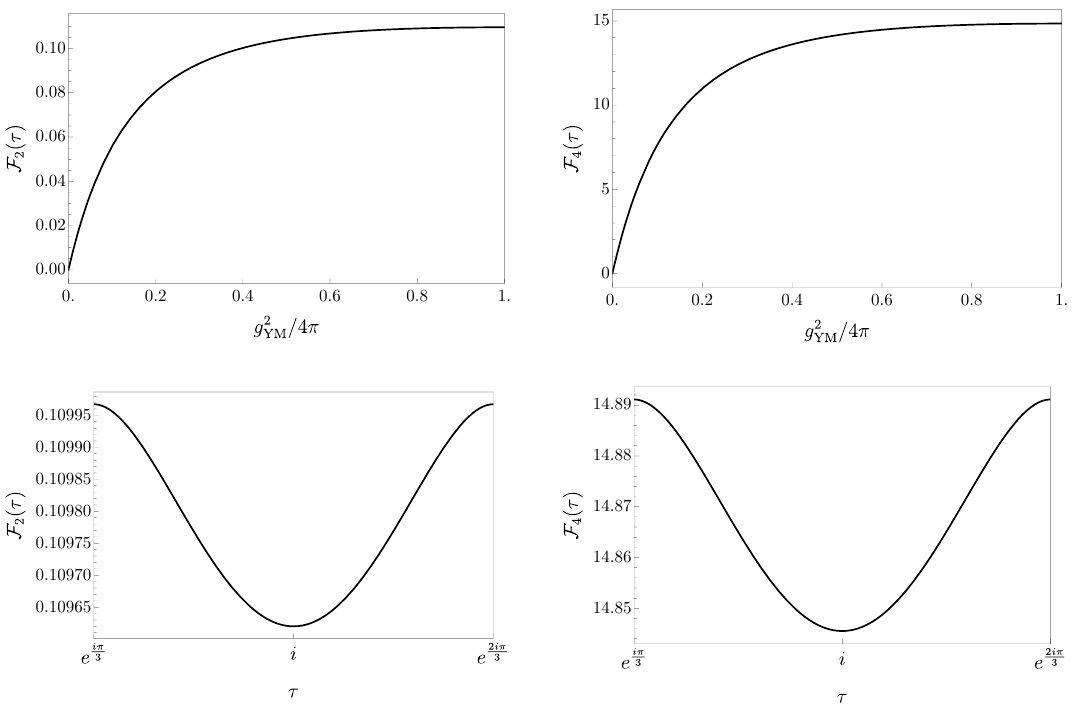
Figure 3 . The localization inputs for SU (3) at θ = 0 as a function of g 2 of τ along the arc from e πi/ 3 to e 2 πi/ 3 ( below ). We include terms with up to 2 instantons in (2.19), which as shown in appendix A is sufficient for convergence inside the fundamental domain. Note that the slope of these inputs goes to zero at the Z 2 self-dual point τ = i and at the Z 3 self-dual point τ = e πi/ 3